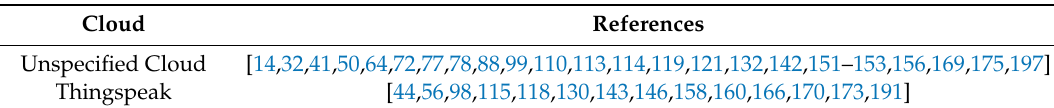
Figure 27. Number of papers that employ each clouds service or platform.